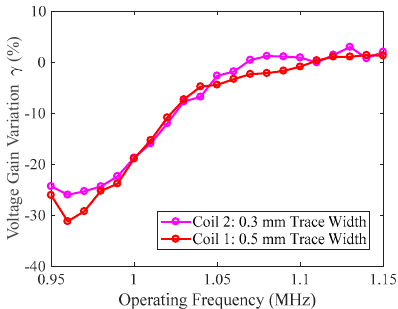
Figure 17. Measurements of γ varying with f for Coils 1, 3, and 5.